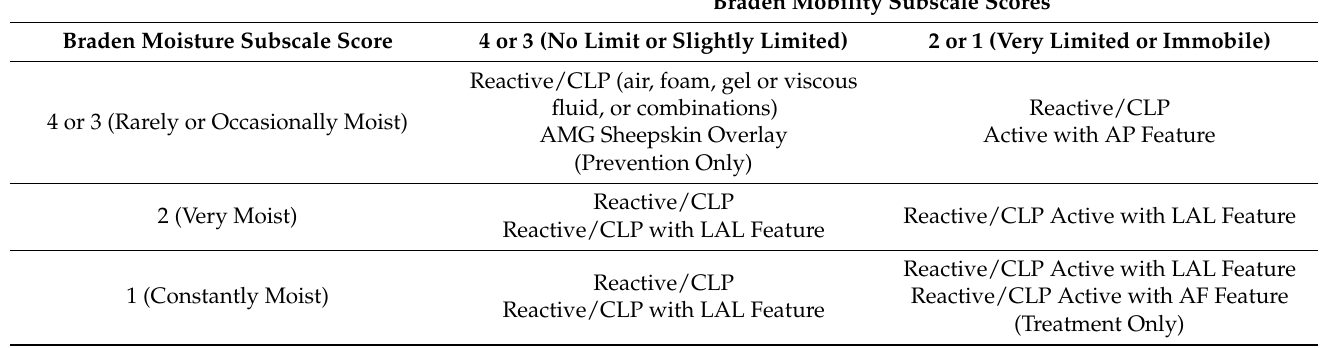
Suggested support surface overlay or mattress selections for pressure-injury pre- vention and treatment based on Braden mobility and moisture subscale scores. AF—air flu- idized; AMG—Australian Medical Grade; AP—alternating pressure; CLP—constant low